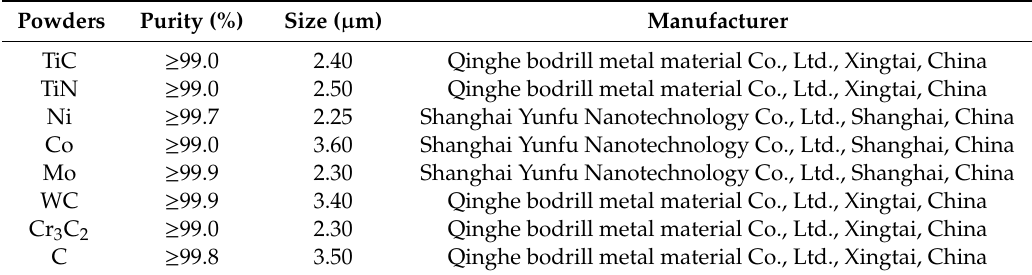
Table 1. Basic information about raw powders.